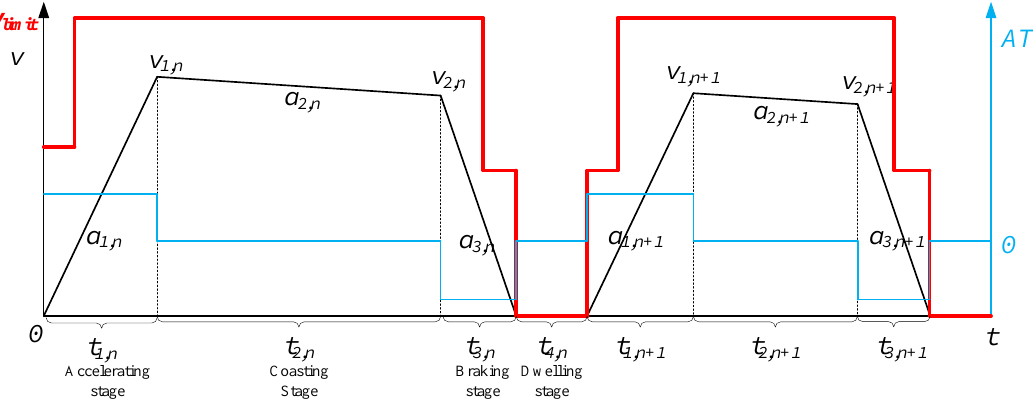
Figure 2. The schematic diagram of the driving